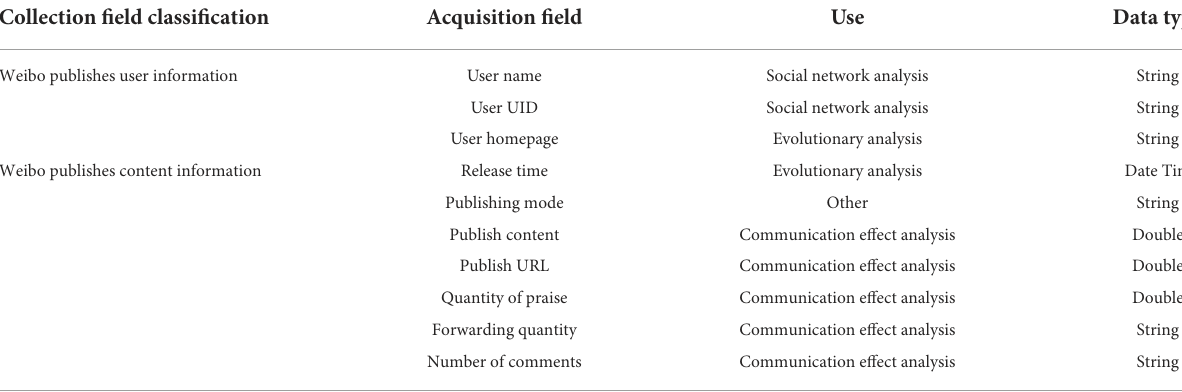
TABLE 2 Online community data collection fields. Collection field